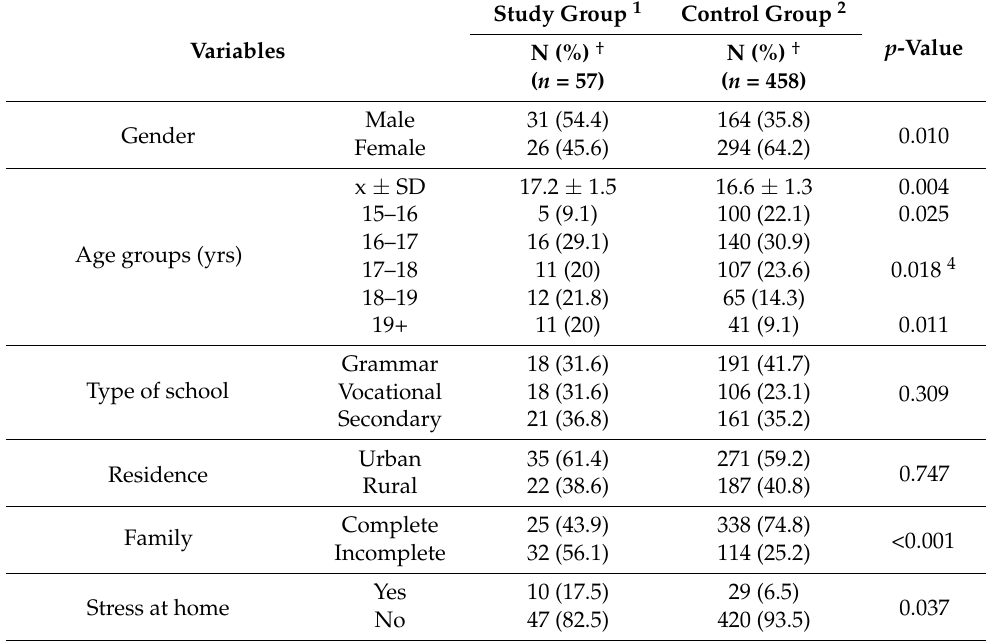
Table 2. Characteristics of selected variables associated with non-attendance at dental preventive care in the sample of adolescents ( n = 515)